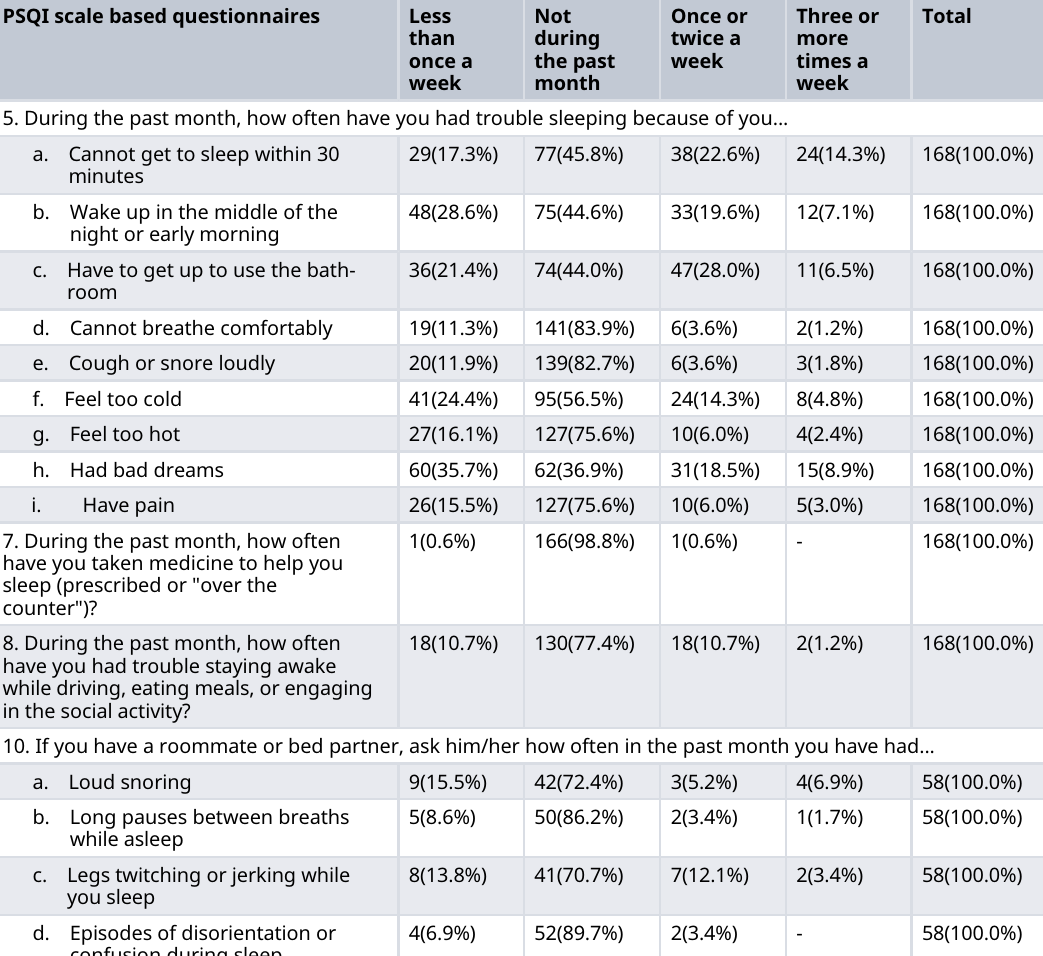
Table 2. Factors affecting sleep in last month at the time of response to the survey. PSQI scale based